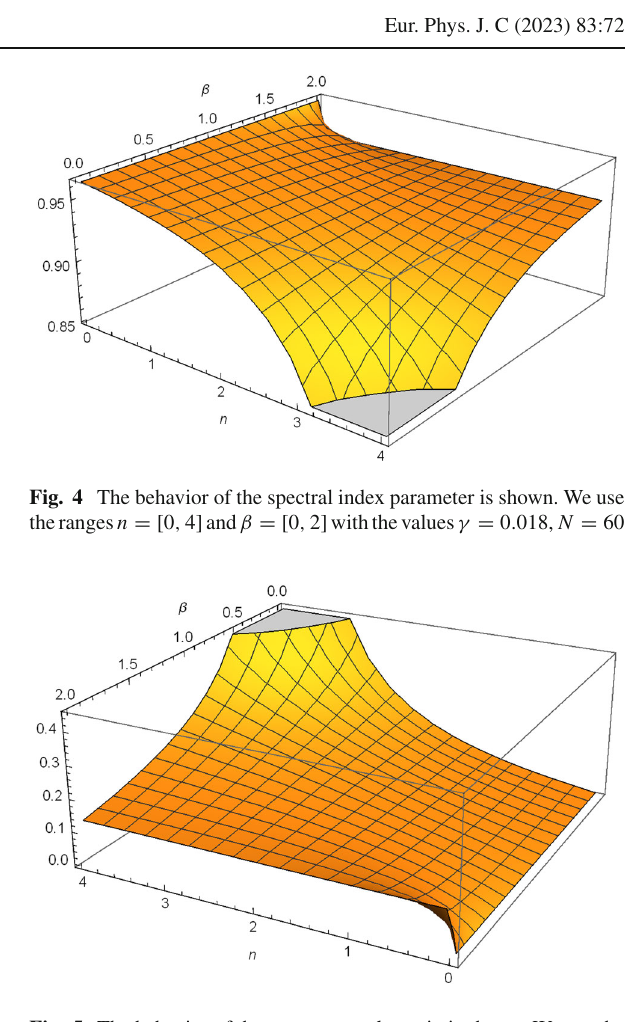
Fig. 5 The behavior of the tensor-to-scalar ratio is shown. We use the ranges n = [ 0 , 4 ] and β = [ 0 , 2 ] with the values γ = 0 . 018, N =